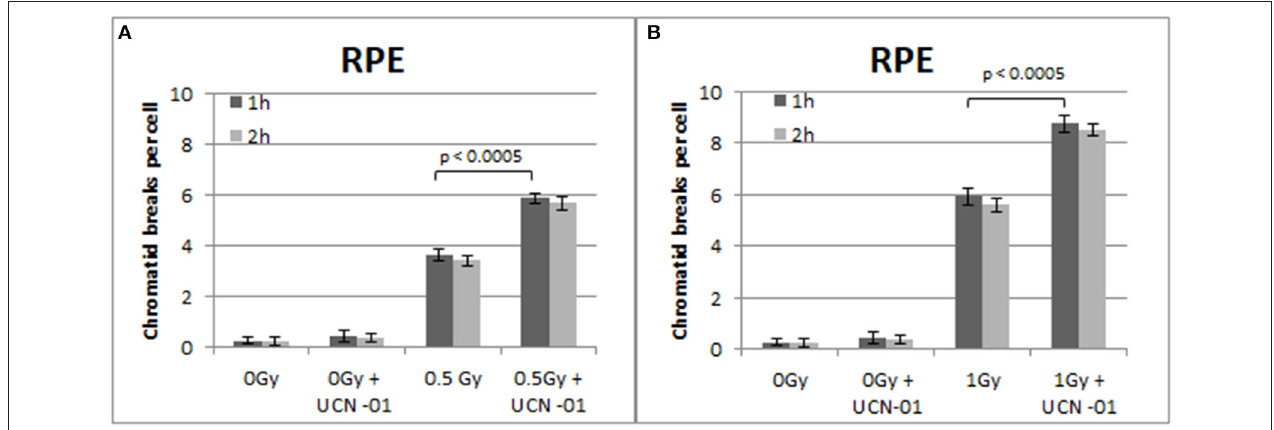
FIGURE 7 | (A) Yield of chromatid breaks in the RPE cells, treated with UCN-01 or left untreated, following exposure to 0.5Gy. (B) As in (A) for cells exposed to 1Gy. Other details as in Figure 2 (Mean ± SD based on three independent experiments; statistically significance criterion: p ≤ 0.05).